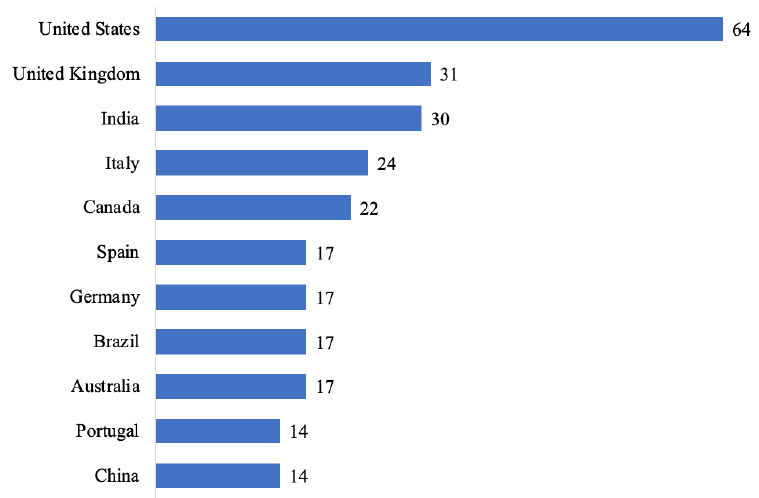
Figure 2. The top 11 countries with the highest number of publications on social entrepreneurship and the entrepreneurial ecosystem. Source: own elaboration.